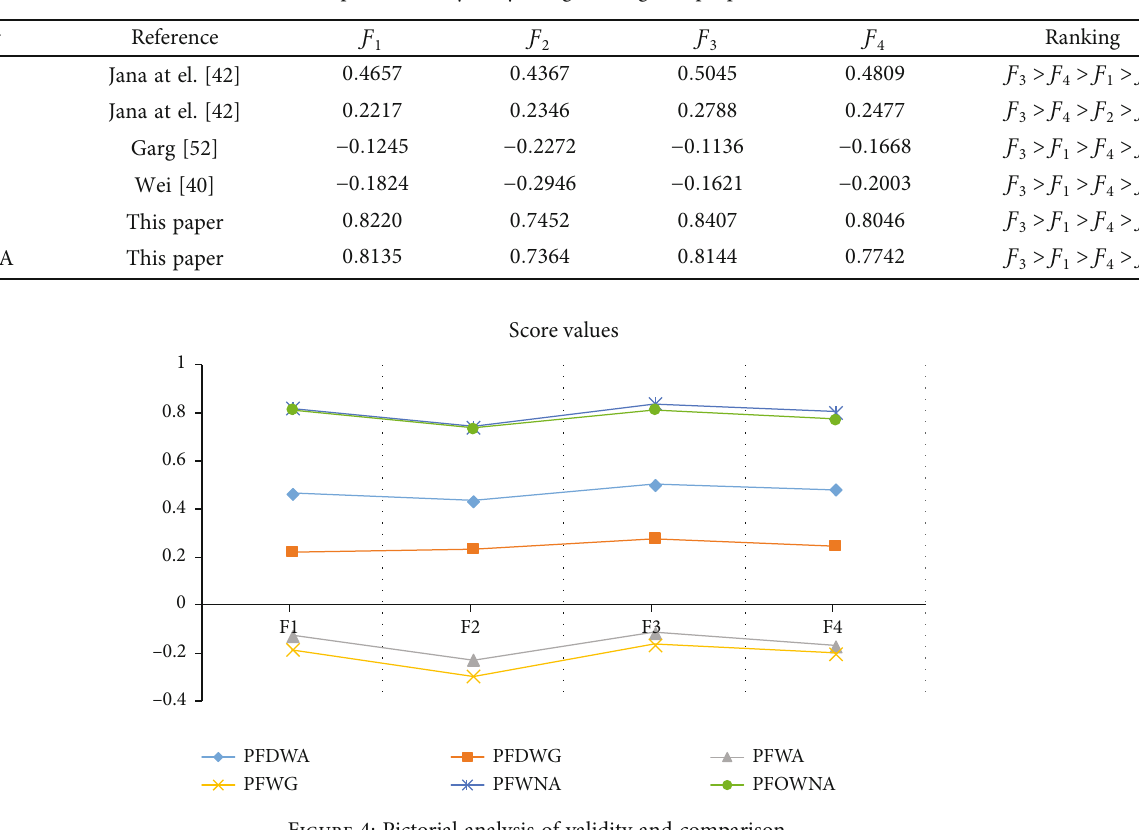
Table 5: Comparative analysis by using existing and proposed methods.